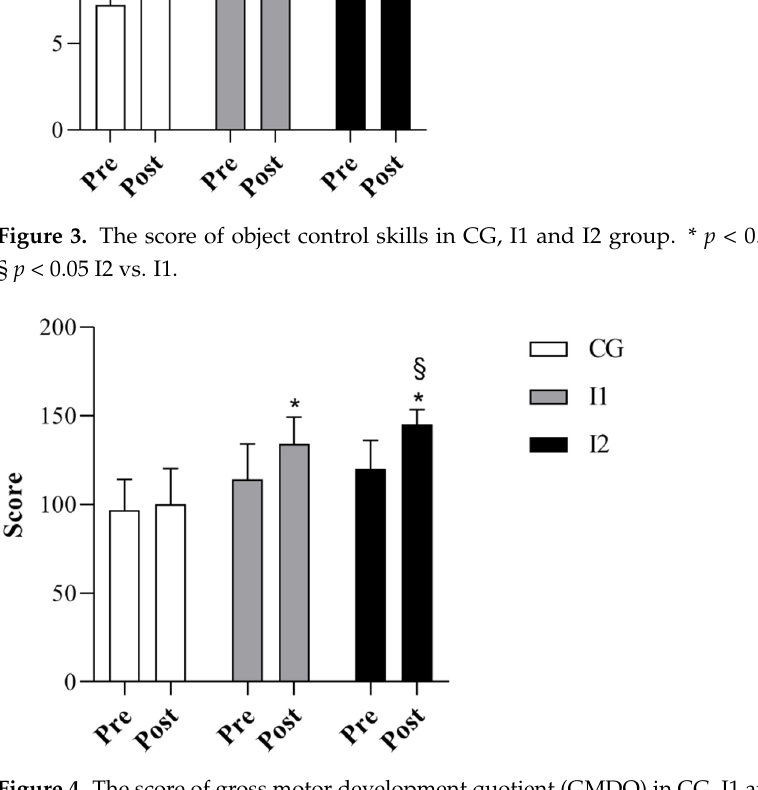
Figure 4. The score of gross motor development quotient (GMDQ) in CG, I1 and I2; * p < 0.001 I1 and I2 vs. CG; § p < 0.05 I2 vs. I1.